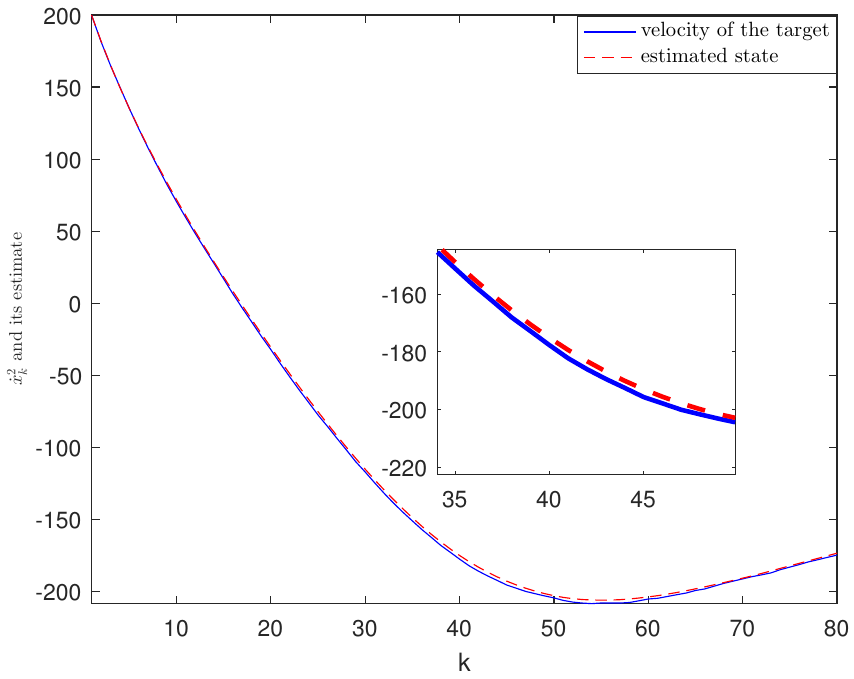
Figure 9. The velocity of the target ˙ x 2, k and its estimate.